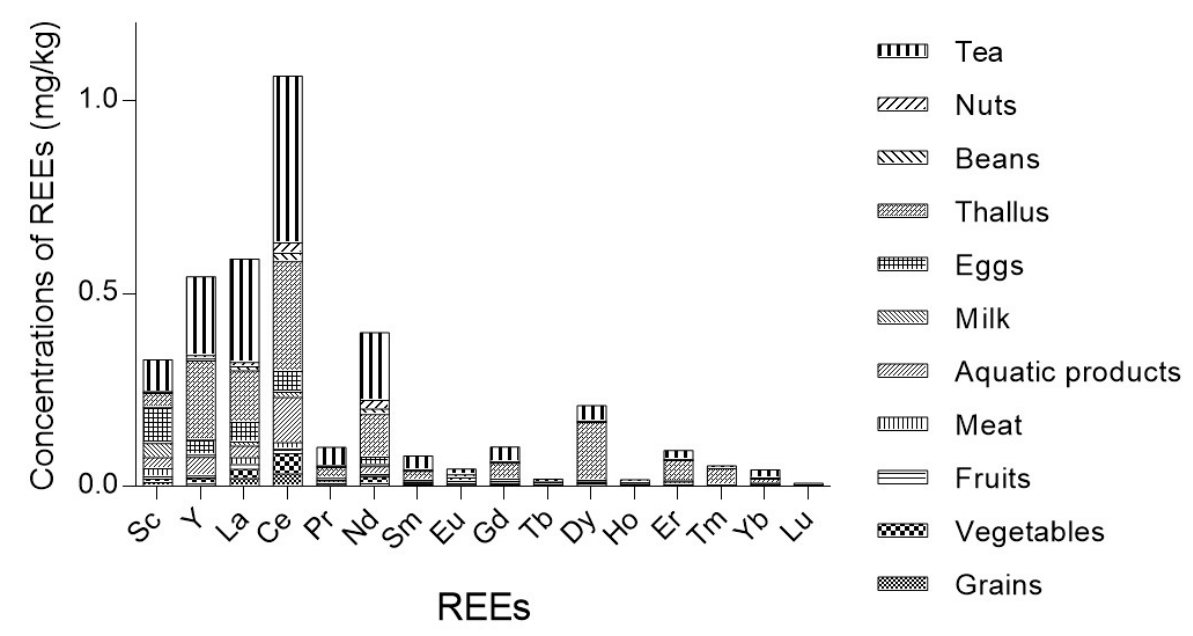
Figure 1. The distribution patterns of 16 REEs in different food categories.